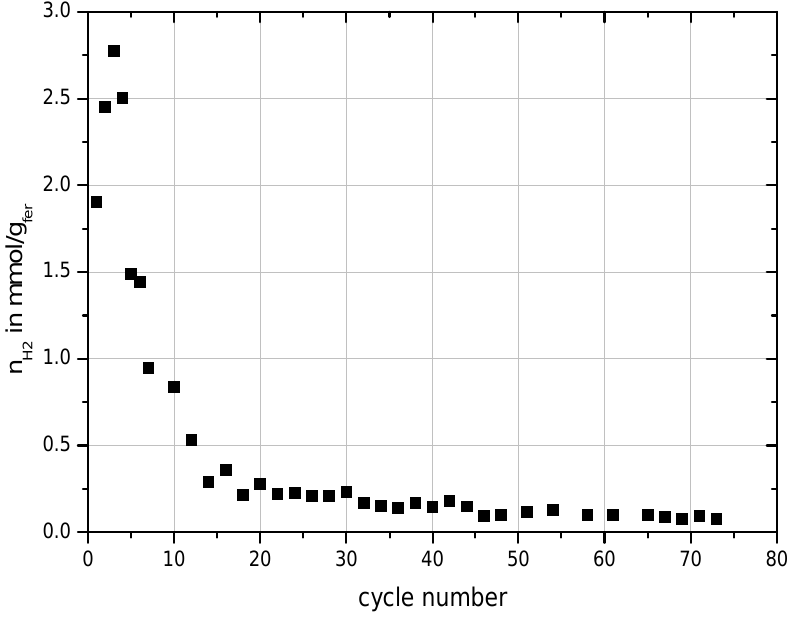
Figure 5. Specific hydrogen production over cycle number performed with Monolith